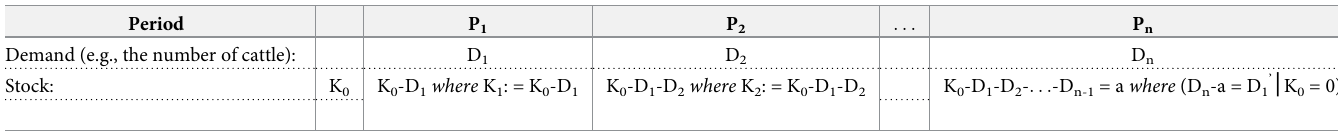
Table 1. Matching the starting stock with 0 starting stock.